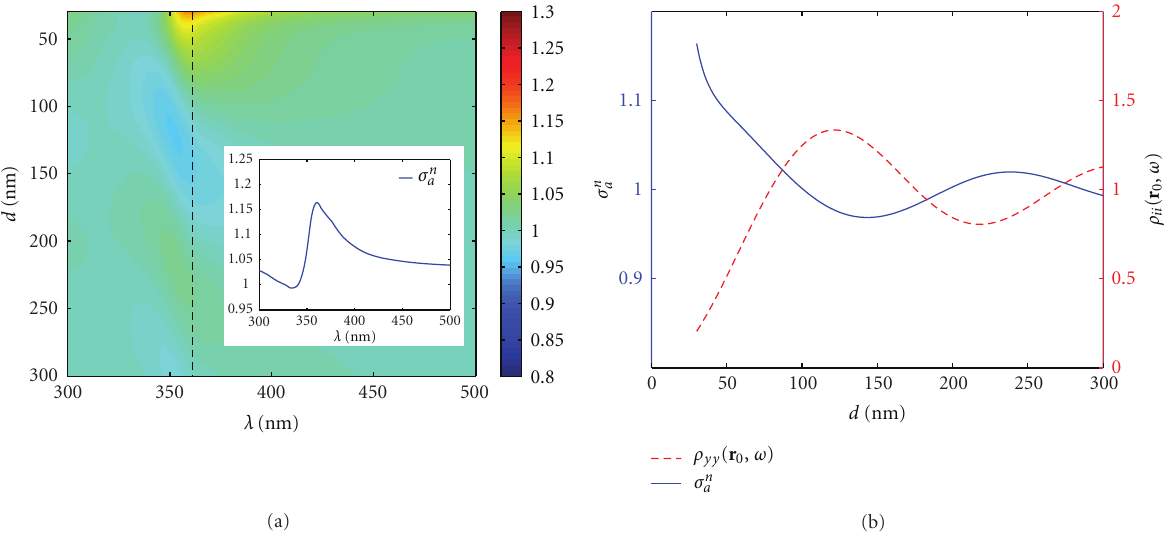
Figure 4: (a) map of the normalized absorption cross-section σ n a versus both the wavelength λ and the distance d between the mirror and the nanosphere. The vertical dashed line is a guide to precise the wavelength at which panel (b) has been plotted. Inset: plot of the absorption cross-section as a function of the wavelength for d = 30nm. (b) plot of σ n a and of the partial LDOS ρ yy ( r 0 , ω ) versus the distance d for λ = 361nm. s -polarized illumination.